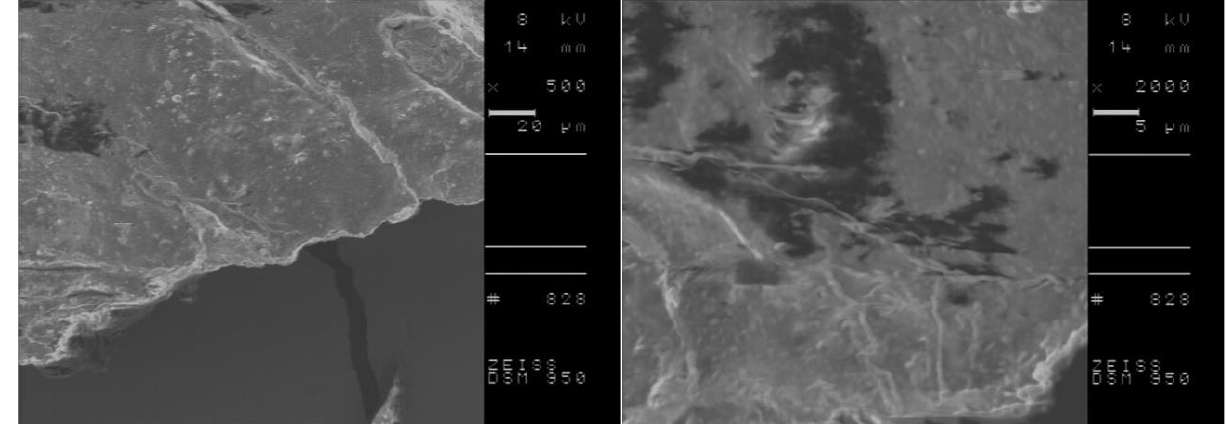
Figure 7. The SEM micrographs of [L-IleOiPr][KETO]; in the top row: before the conditioning step and in the bottom row: after the conditioning step; on the right: enlarged 2000 times SEM image; on the left side lower magnification (enlarged 500 times respectively).